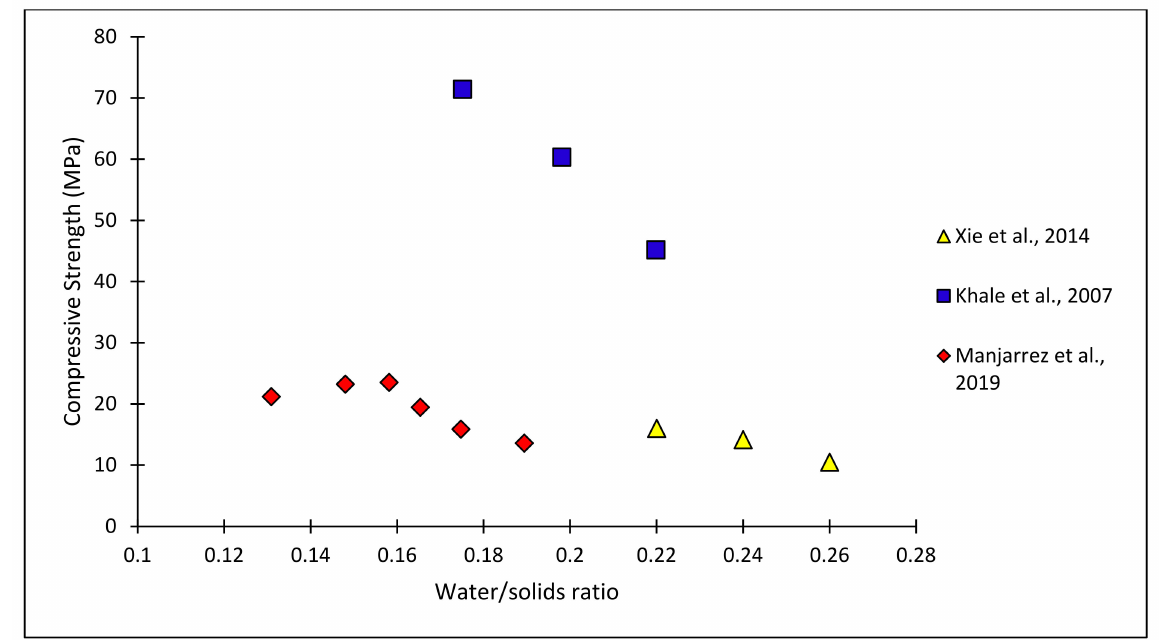
Figure 6. Graph compiling compressive strength data versus water/solids ratio obtained in previous investigations